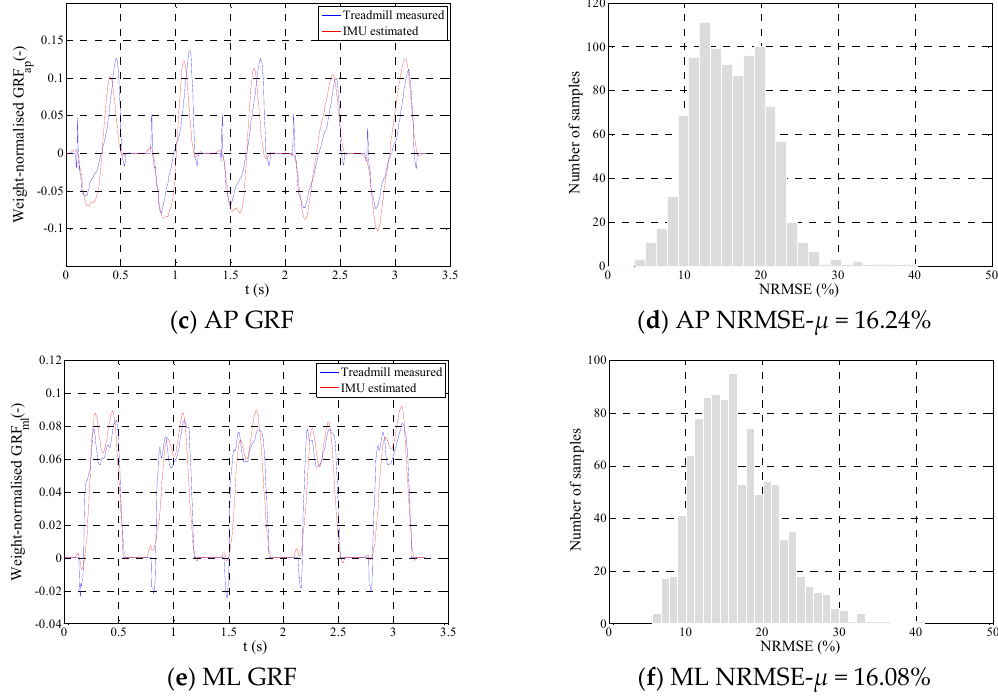
Figure 9. Performance of TPM when applied to inertial measurement units (IMU) data.